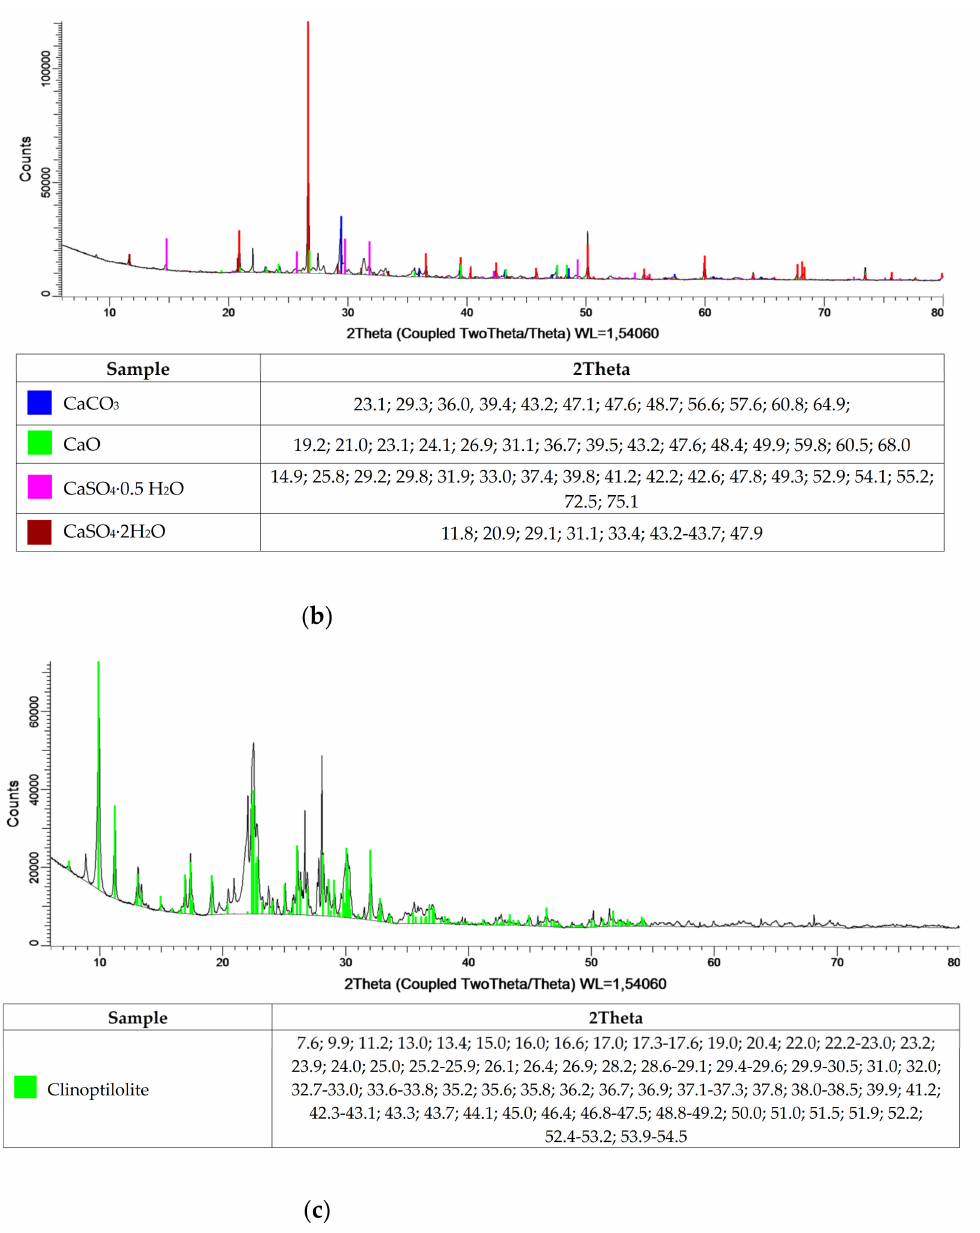
Figure 1. XRD characterization of cement ( a ), slag ( b ) and zeolite ( c